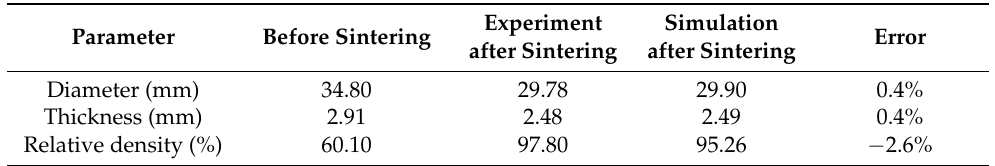
Table 2. Parameters comparison for round specimen of